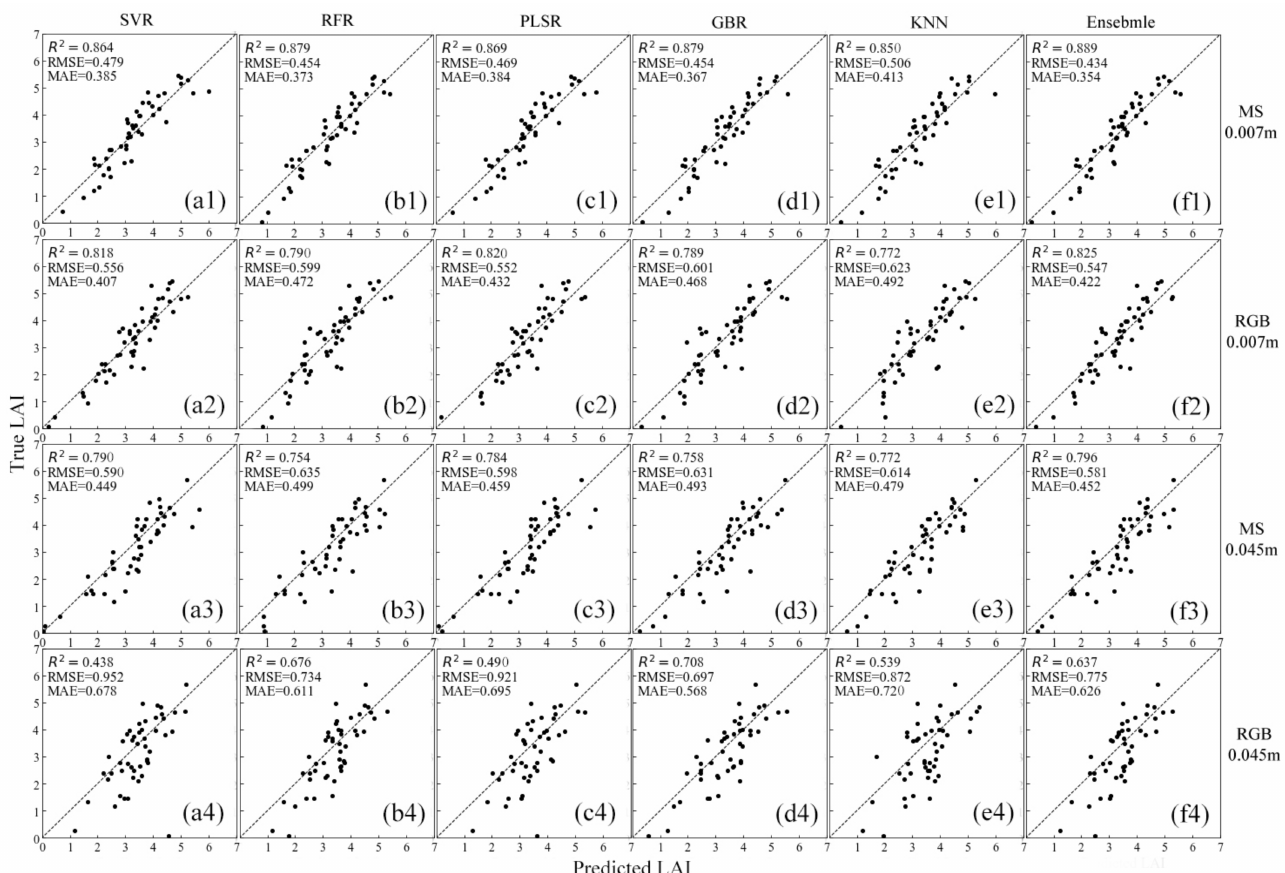
Figure 12. Scatter plots of predicted and true LAI values from ( a ) SVR, ( b ) RFR, ( c ) PLSR, ( d ) GBR, ( e ) KNN and ( f ) ensemble model for ( 1 ) 0.007 m GSD MS dataset, ( 2 ) 0.007 m GSD RGB dataset, ( 3 ) 0.045 m GSD MS dataset and ( 4 ) 0.045 m GSD RGB